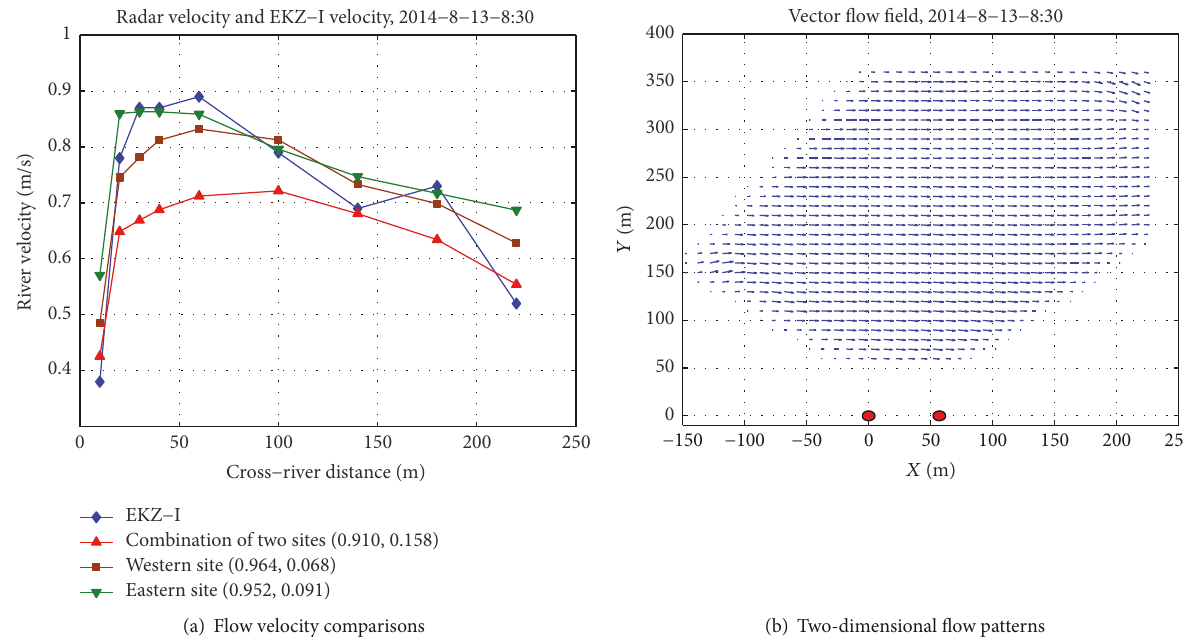
Figure 16: The comparison of the results between USDPR and